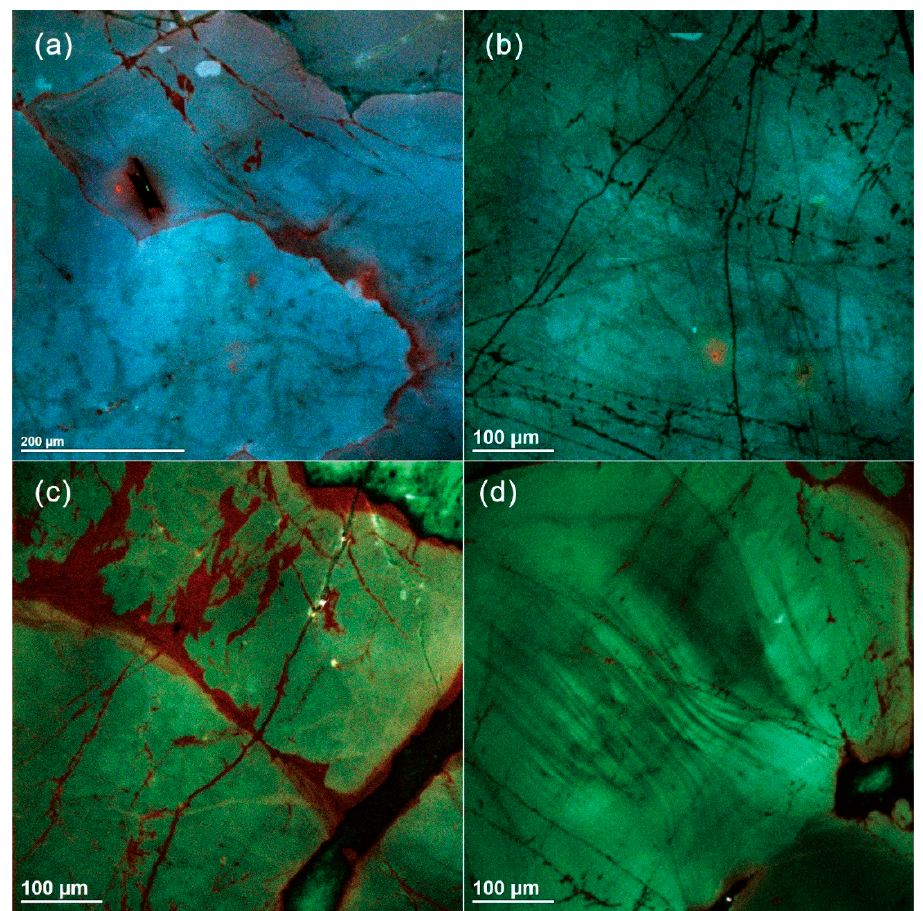
Figure 4. Scanning electron microscope–cathodoluminescence (SEM–CL) images of quartz from the Nashwaak Granite. In the two-mica granite, ( a ) visible oscillatory zoning parallel to grain boundary and ( b ) homogeneous quartz with fractures. In the biotite granite, ( c ) homogenous quartz with fluids infiltration along fractures and ( d ) oscillatory zoning.